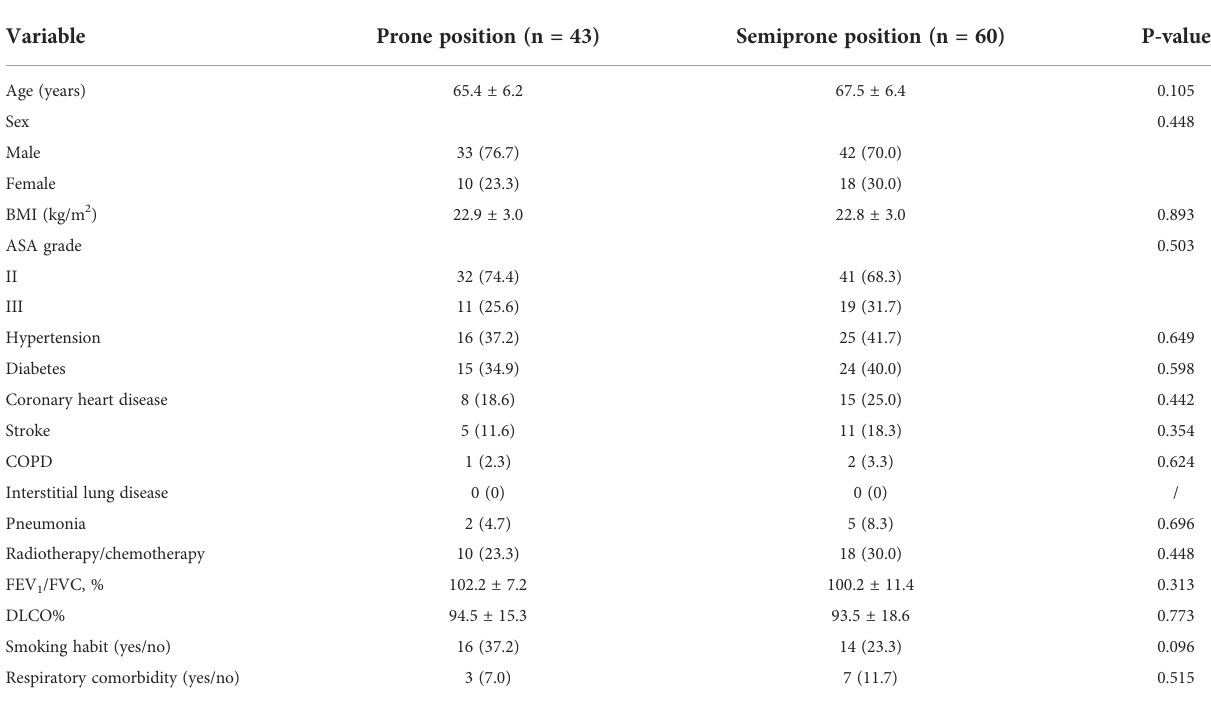
TABLE 1 Preoperative patient characteristics.